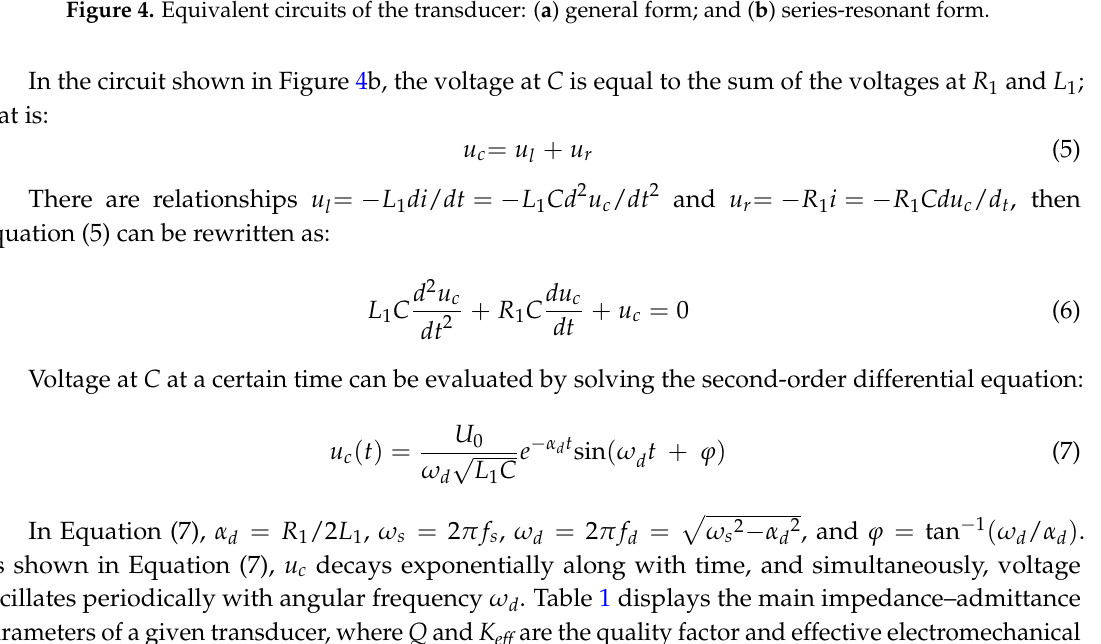
Table 1. Main impedance–admittance parameters of a given transducer.